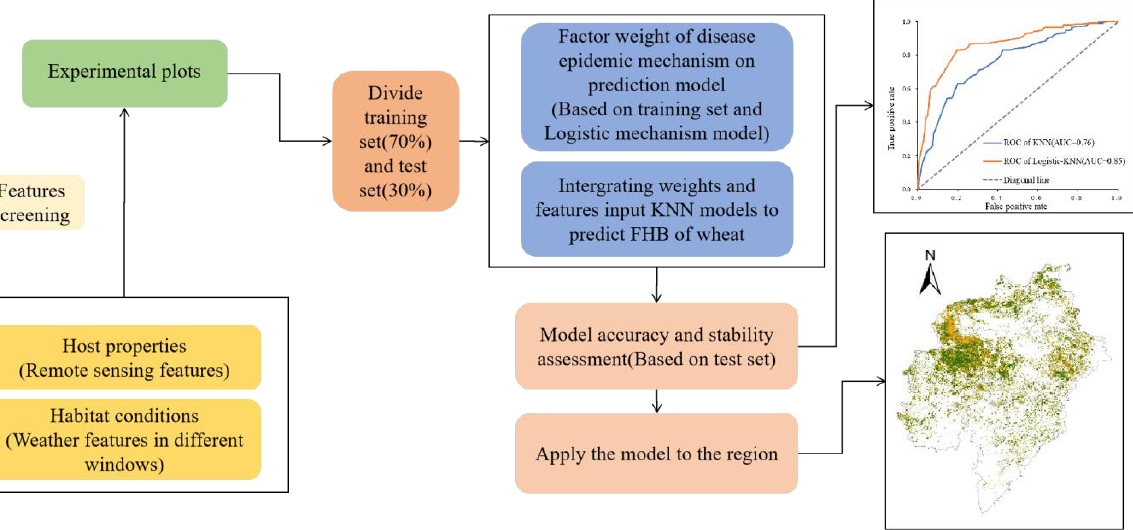
Figure 2. Flow chart of remote sensing-based prediction of wheat FHB area and